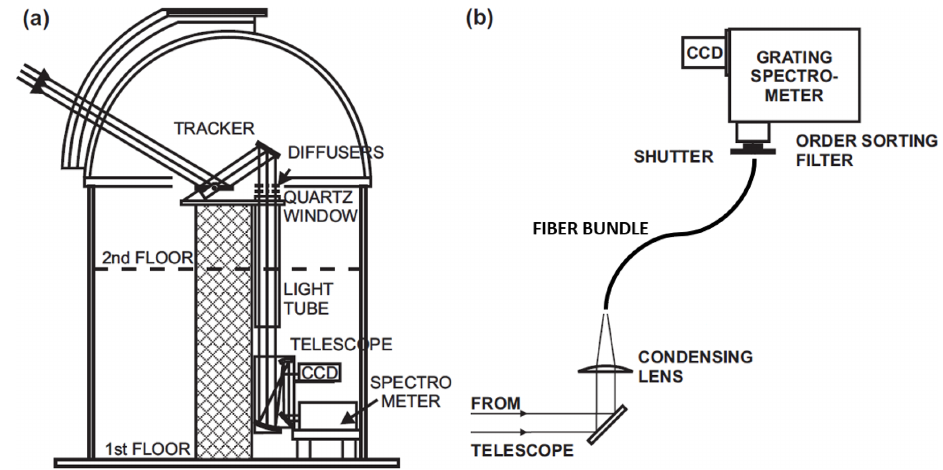
Figure 1. Schematic of the instrument light path over the Table Mountain Facility (TMF, 2.286km above mean sea level, 34.38 ◦ N, 117.68 ◦ W, Wrightwood, California, USA). (a) Light is collected by the primary of the heliostat (tracker), reflected down to the telescope on the first floor, which conditions it to a 7cm diameter beam. (b) The light is then reflected to a condensing lens into a fiber optic bundle, past a shutter and order-sorting filter, and then into the spectrometer. The fiber bundle contains 19 fibers in a round pattern at the entrance, and at the exit fibers are arranged in a line pattern that is set parallel to the spectrometer